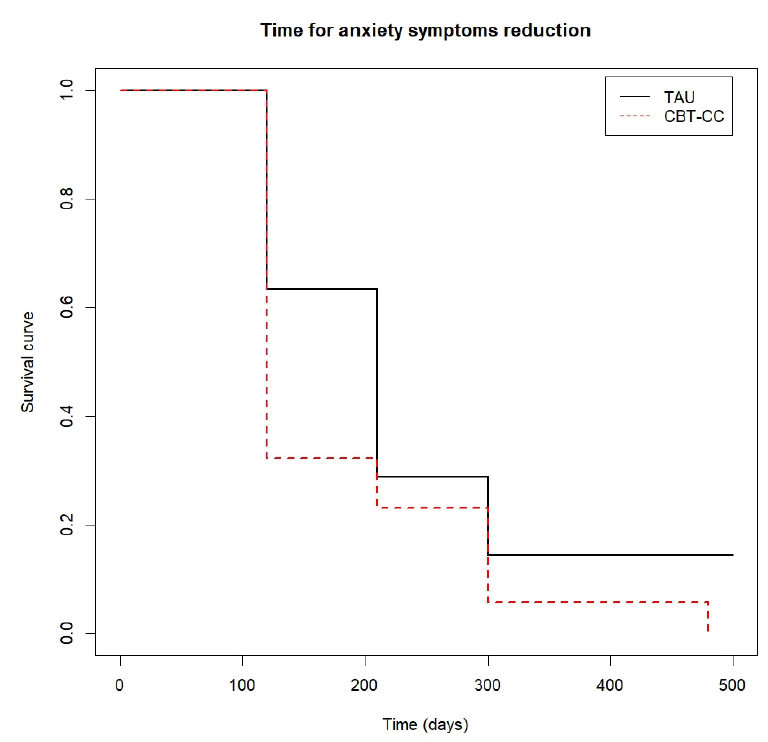
Figure 5. Time to anxiety symptoms reduction.